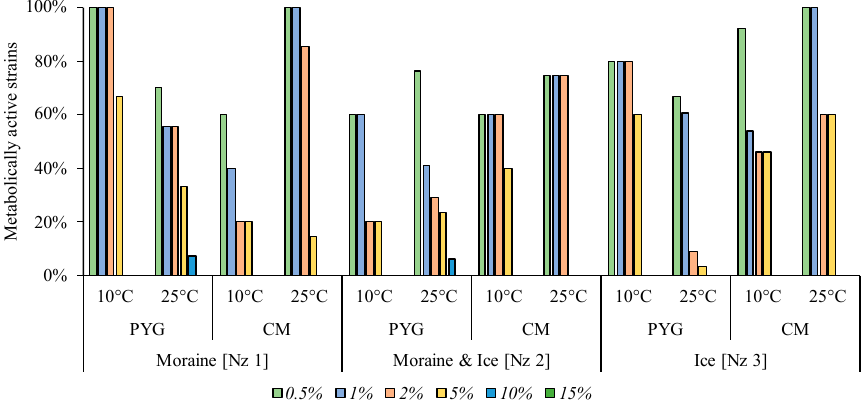
Figure 12. Isolated strains’ resistance to the presence of magnesium perchlorate in nutrient medium. Vertical axis: proportion of the strains in the culturable community able to reproduce in considered conditions. Horizontal axis: the tested communities. Temperature and medium abbreviations indicate the isolation conditions. PYG and CM—peptone yeast glucose and modified Czapek media, respectively. Detailed data on the individual strain resistance to temperature, pH, and salts are presented